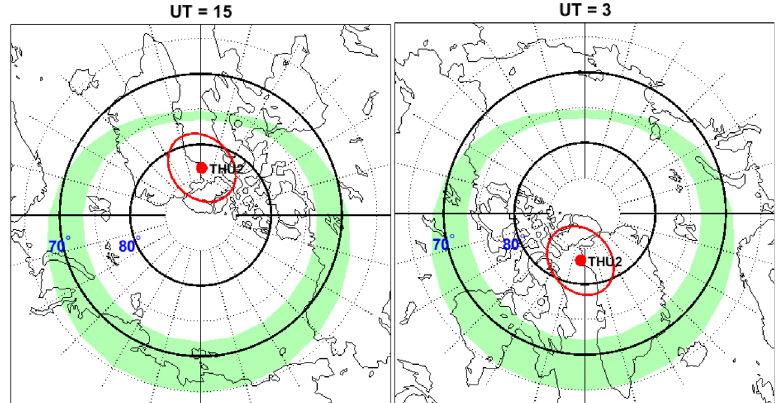
Fig. 1. The data coverage of THU2 data in geomagnetic latitude/magnetic local time coordinates. The red circle is the data coverage (extent of pierce points) of GPS data at a cutoff elevation of 30 (cid:3) by assuming pierce points at 350 km altitude. The left panel shows the data coverage at 15:00 UT when THU2 is located around magnetic noon, while the right panel shows for 3:00 UT when THU2 is located around magnetic midnight. The green shaded area is the auroral oval derived from the Feldstein model for Q